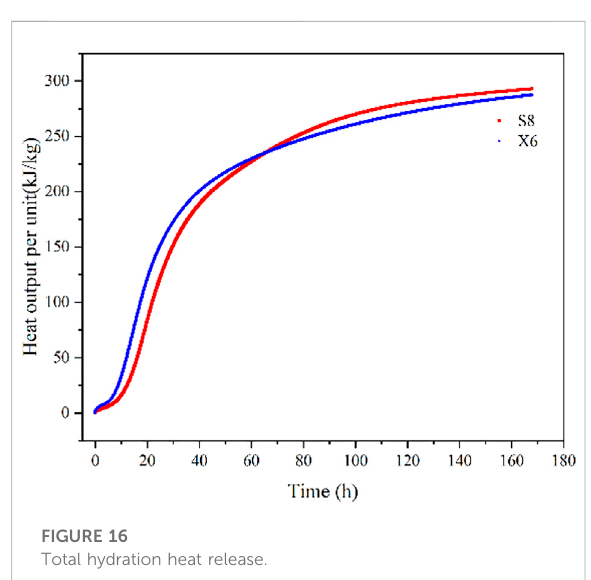
FIGURE 15 Speed of hydration heat release.